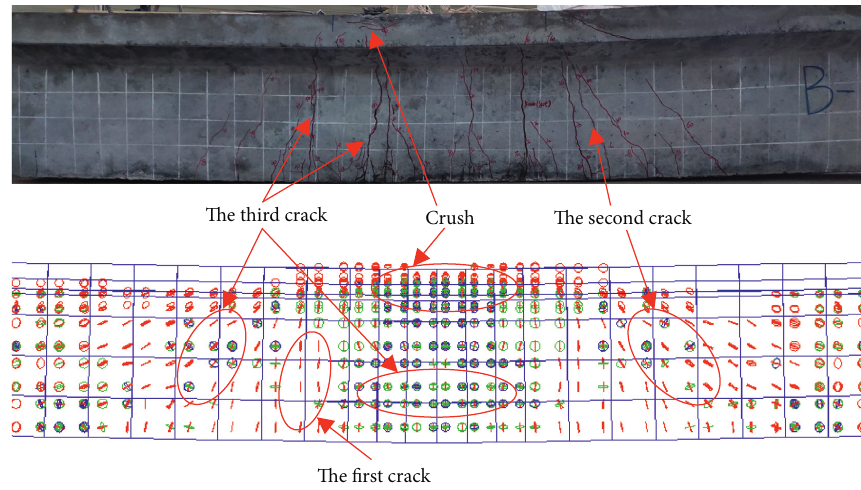
Figure 12: Comparison of concrete cracks from tests and numerical